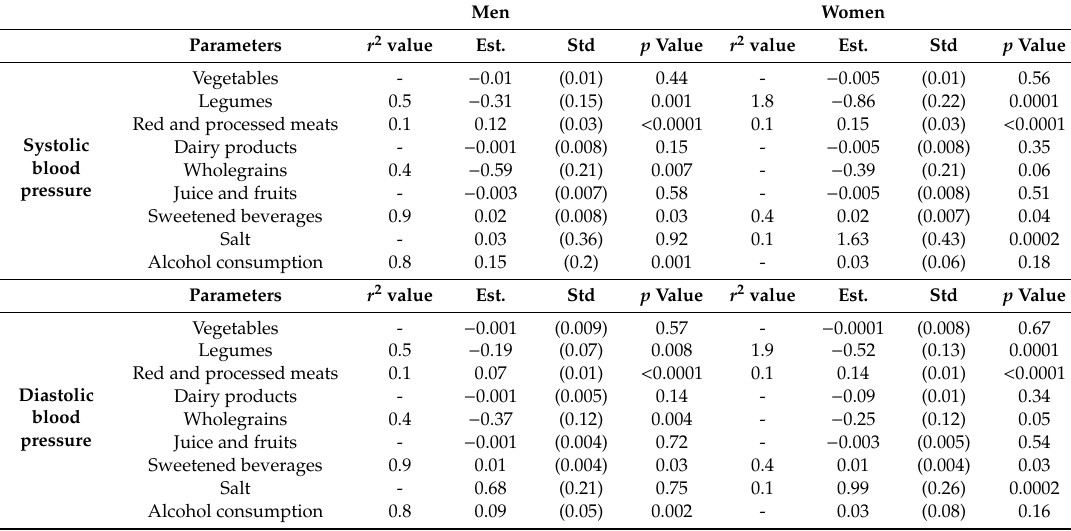
Table 3. Multivariate linear regression including the composed factors of DASH score and alcohol for blood